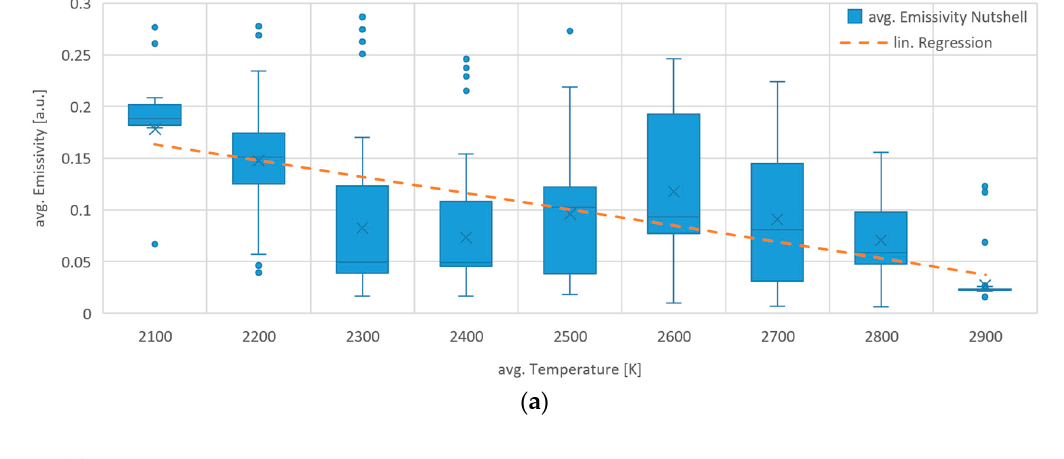
Figure 5. This figure shows an exemplary measured, time-resolved-measured photomultiplier and InSb-detector signals ( a ) and the corresponding calculated temperature ( b ) and emissivity ( c ) of a coal particle. Shaded regions are excluded from the data interpretation.